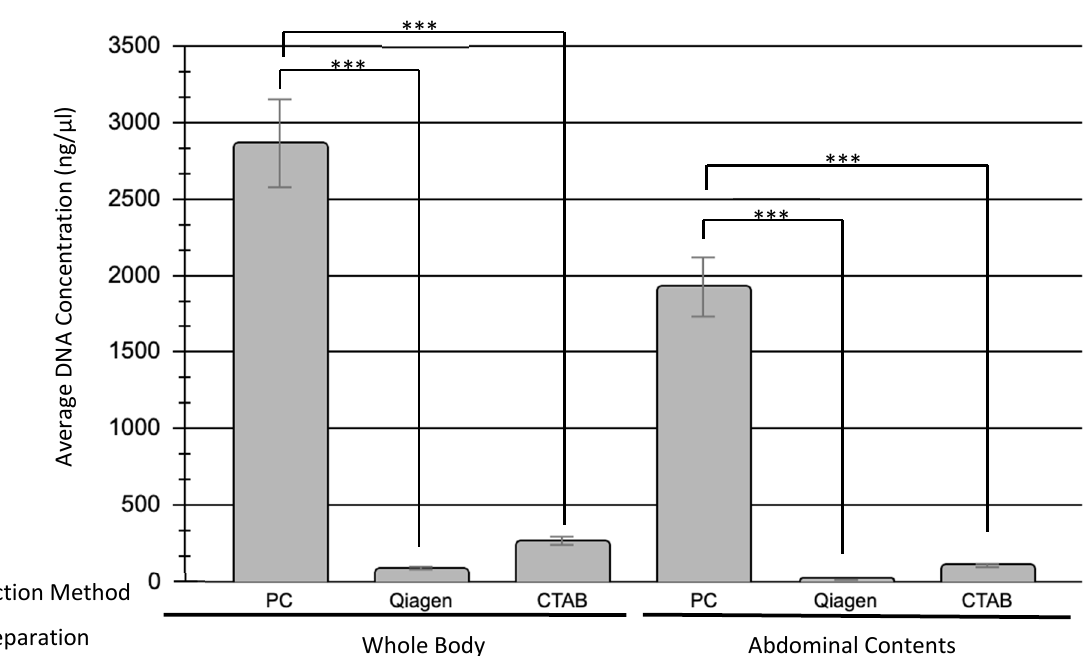
Figure 1. Comparison of DNA concentrations obtained by different DNA extraction methods. Three different DNA extraction methods were investigated: Phenol–chloroform (PC), Qiagen DNeasy Blood & Tissues Kit (Qiagen), and Cetyltrimethylammonium bromide (CTAB). A total of 22 samples were tested with each method, 11 of which used the whole body of the tick while the other 11 used only the abdominal contents. The average DNA concentration obtained using each method is shown here and separated by tick preparation method (whole body versus abdominal contents only). Statistical significance ( p ≤ 0.05) is denoted by asterisks.